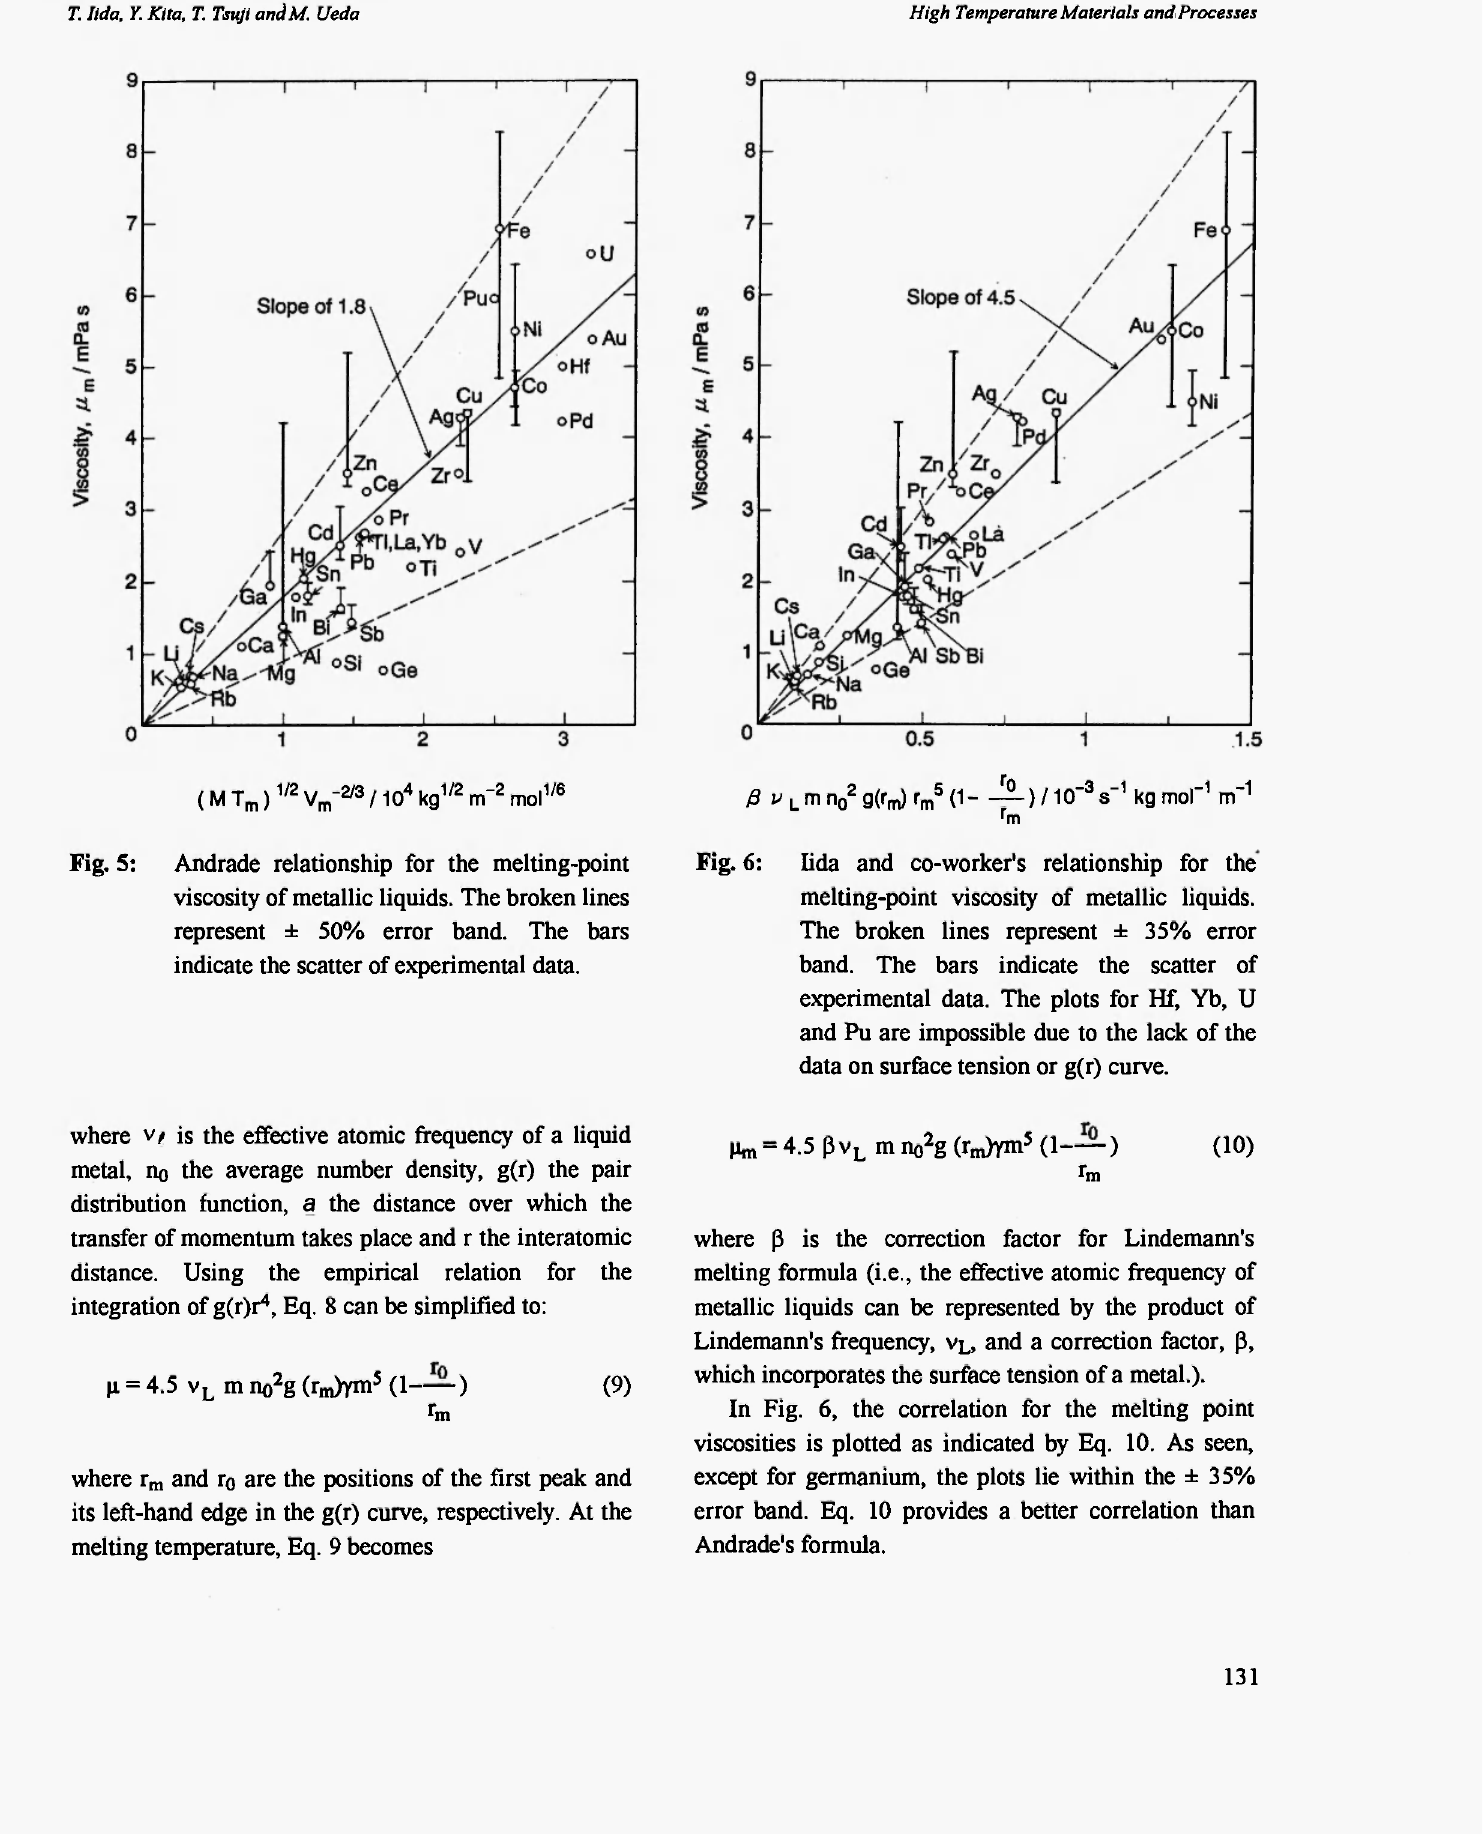
Fig. 5: Andrade relationship for the melting-point viscosity of metallic liquids. The broken lines represent ± 50% error band. The bars indicate the scatter of experimental data.